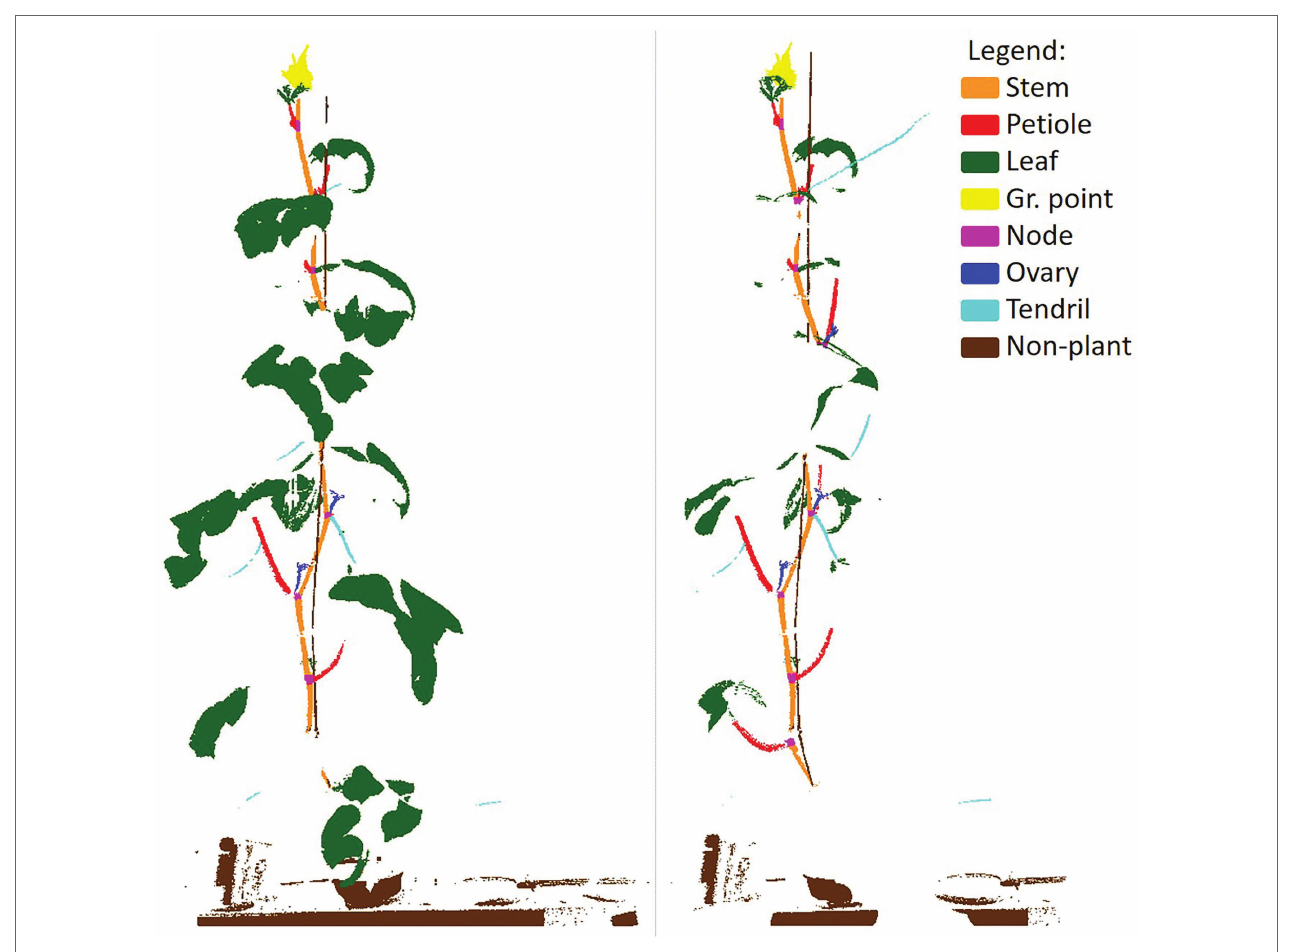
FIGURE 5 | Example of the selected points for the class-independent (left) and the class-dependent (right) training set. The class-dependent training set was more balanced. Note that points could be included multiple times in overlapping chunks, which is not visible in this figure.